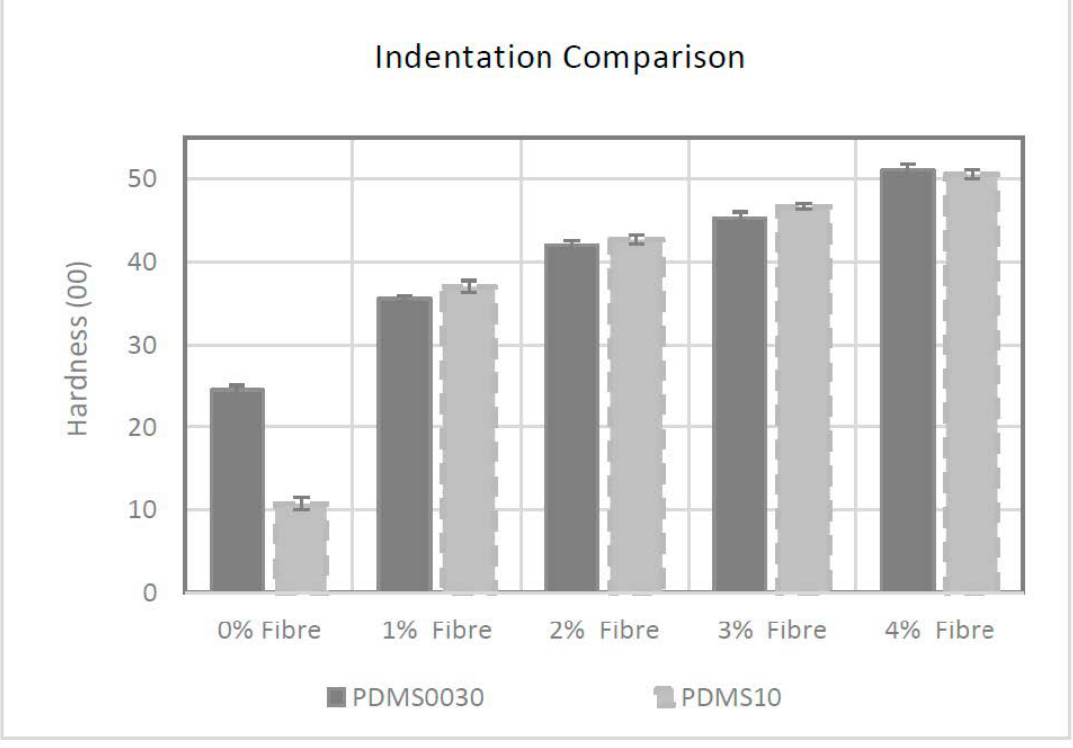
Figure 1. Comparison of hardness values caused by incremental fibre addition on each group of PDMS. The error bars represent the standard deviation in each group.